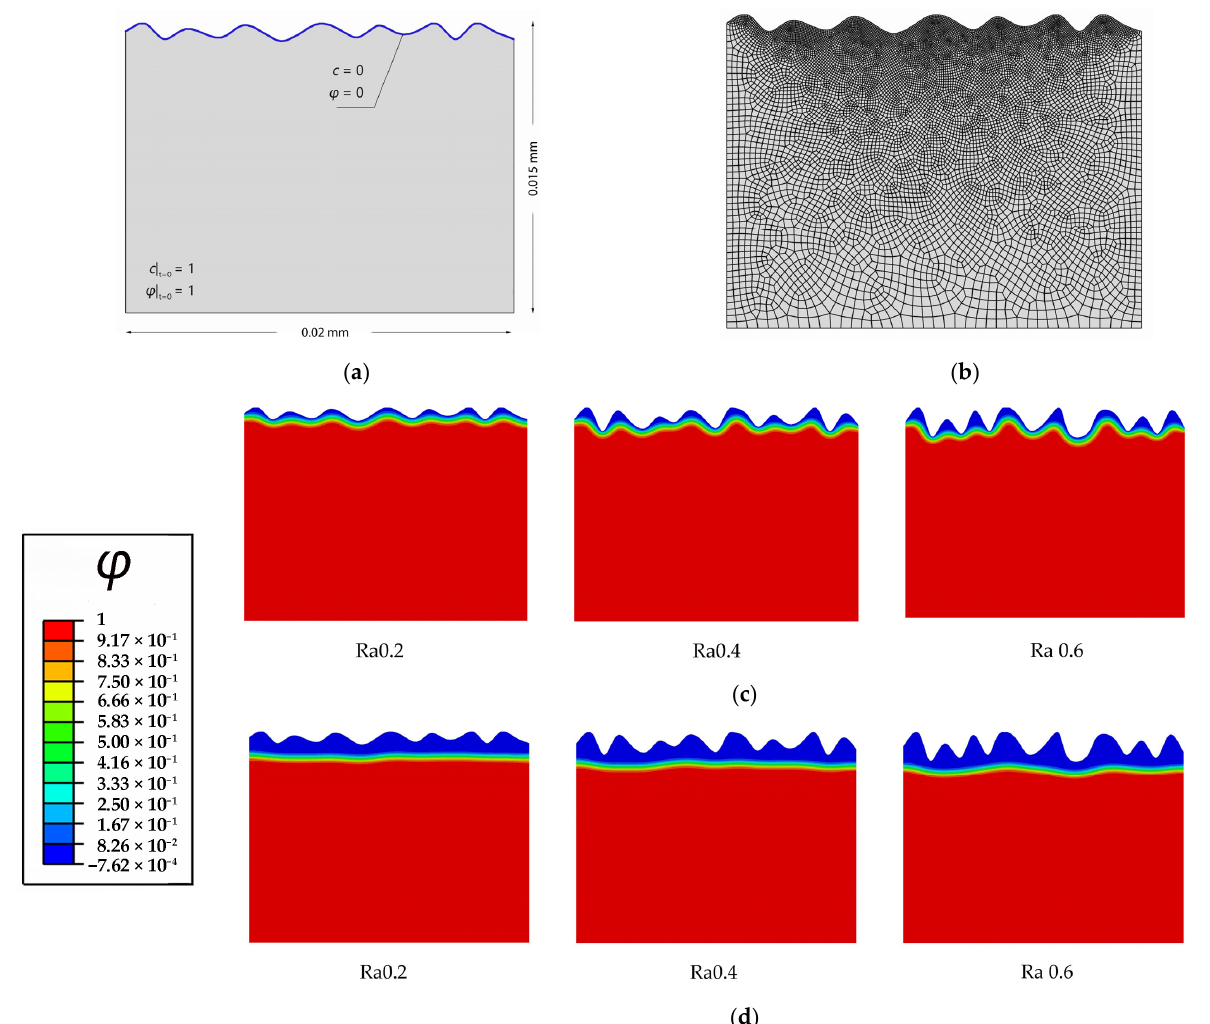
Figure 4. Diffusion-controlled corrosion of Mg with different rough surfaces: ( a ) Schematic of initial and boundary conditions of Mg crystal with a rough surface exposed in pure water; ( b ) finite element mesh; ( c ) corrosion of three surfaces with different surface roughnesses Ra after 5 T s; ( d ) corrosion of three surfaces with different surface roughnesses Ra after 65 T s.